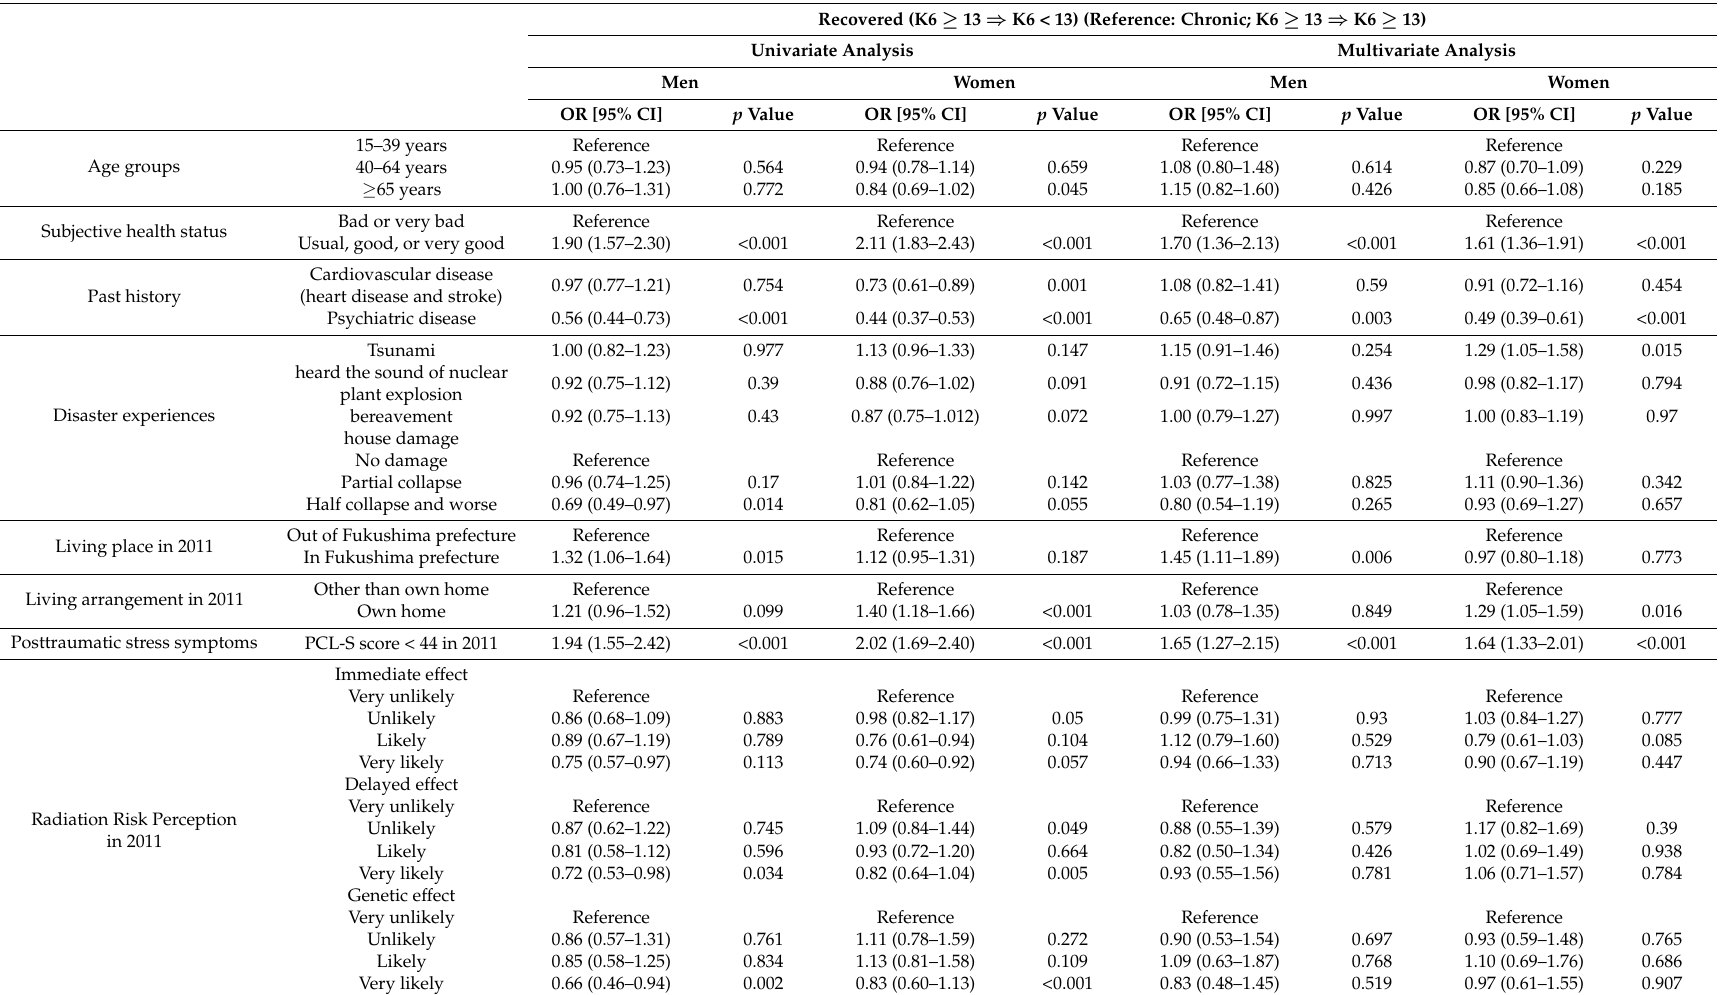
Table 3. Univariate and multivariate analysis by logistic regression comparing recovered with chronic